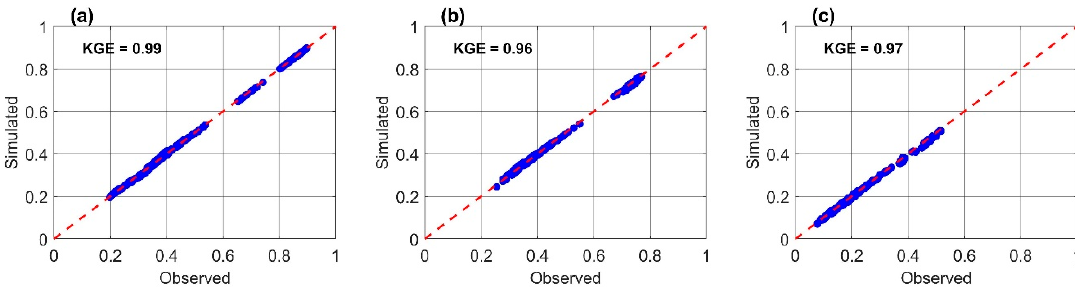
Figure 10. Lag-1 day auto-correlations of the weather variables T x , T N , and WS, respectively, for all